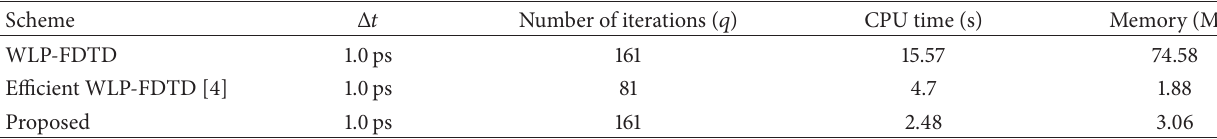
Table 1: Simulation results for the different